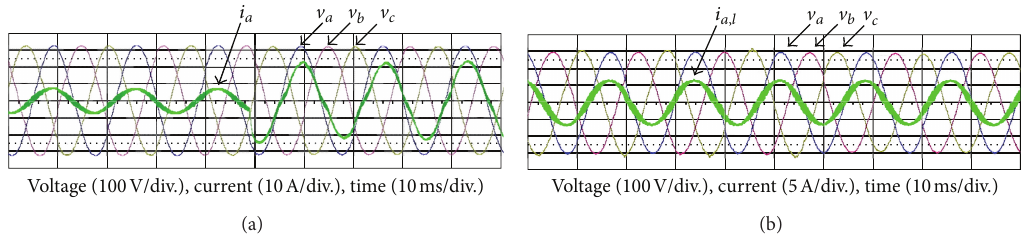
Figure 10: Three-phase voltage and current when the mode is changing; (a) AC load voltages V 𝑎 , V 𝑏 , and V 𝑐 and current 𝑖 𝑎 when the mode is changed from the islanding mode to the grid-connected mode; (b) AC load voltages V 𝑎 , V 𝑏 , and V 𝑐 and AC load current 𝑖 𝑎,𝑙 when the mode is changed from the grid-connected mode to the islanding